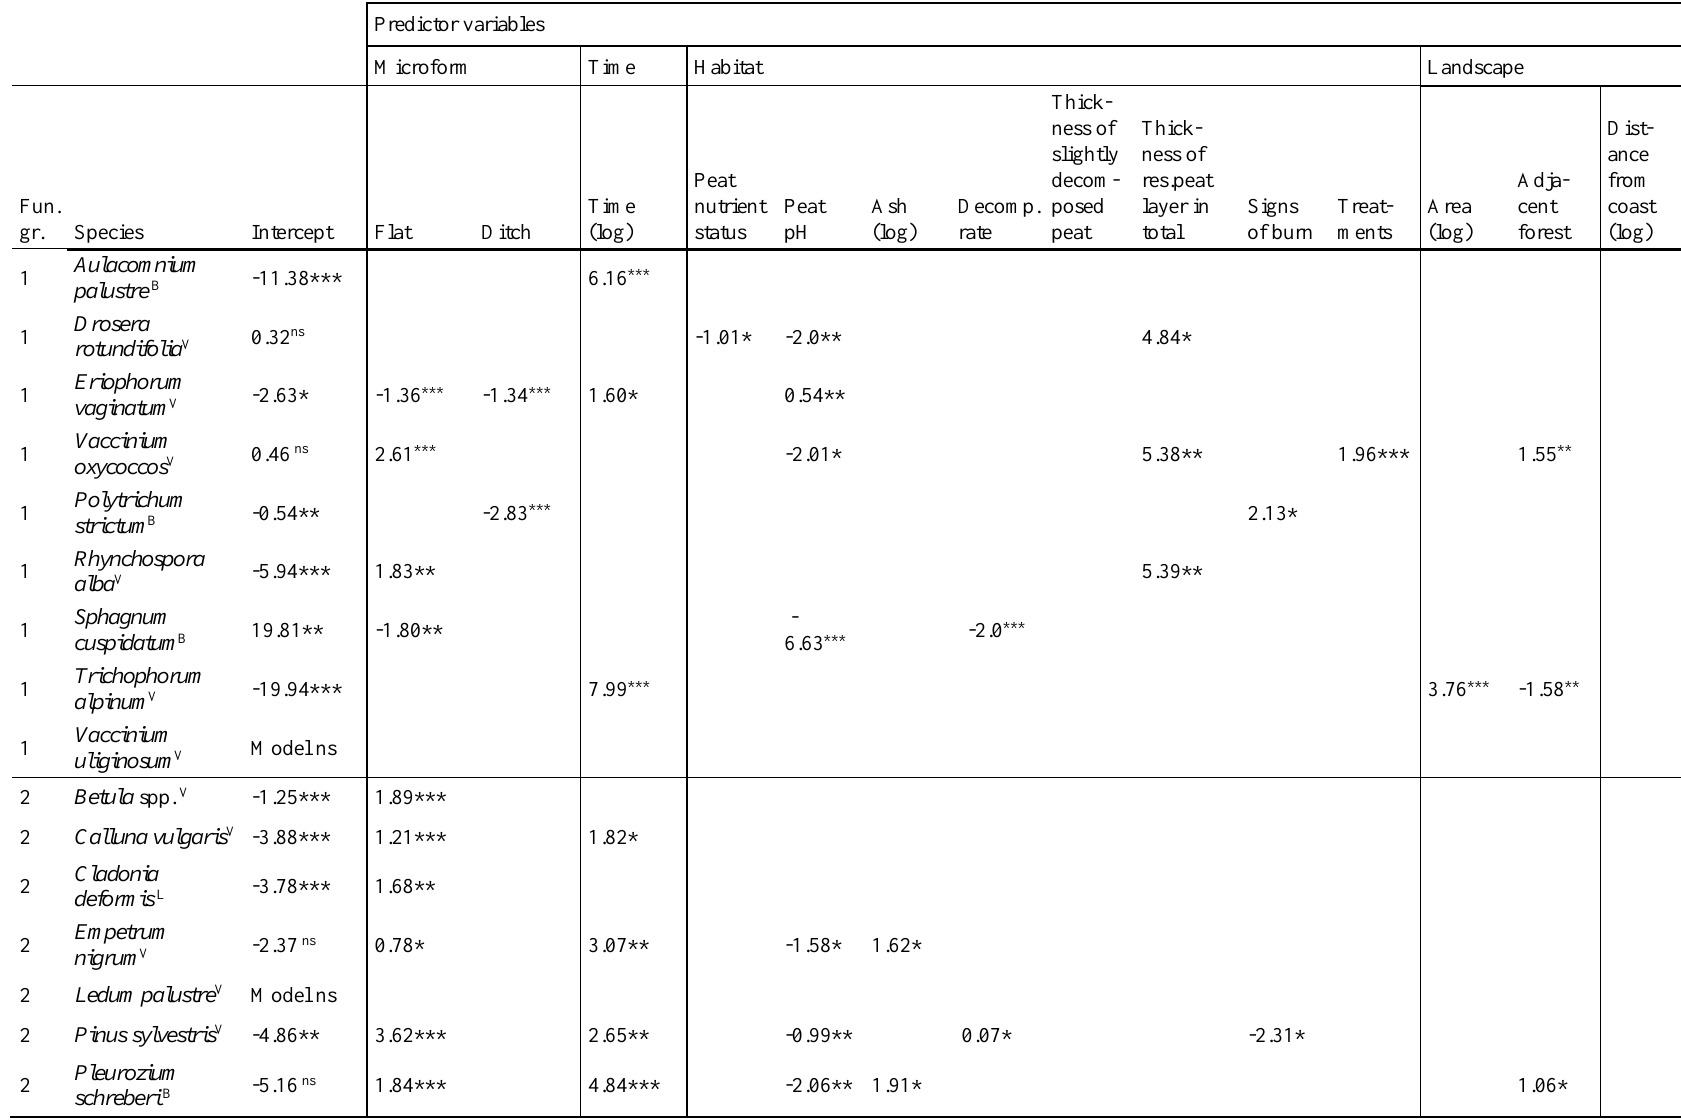
Table 1. Generalised linear model analysis showing slopes of the relationships between the most frequent species (core species) and environmental variables. Predictor variables Microform Time Habitat Landscape